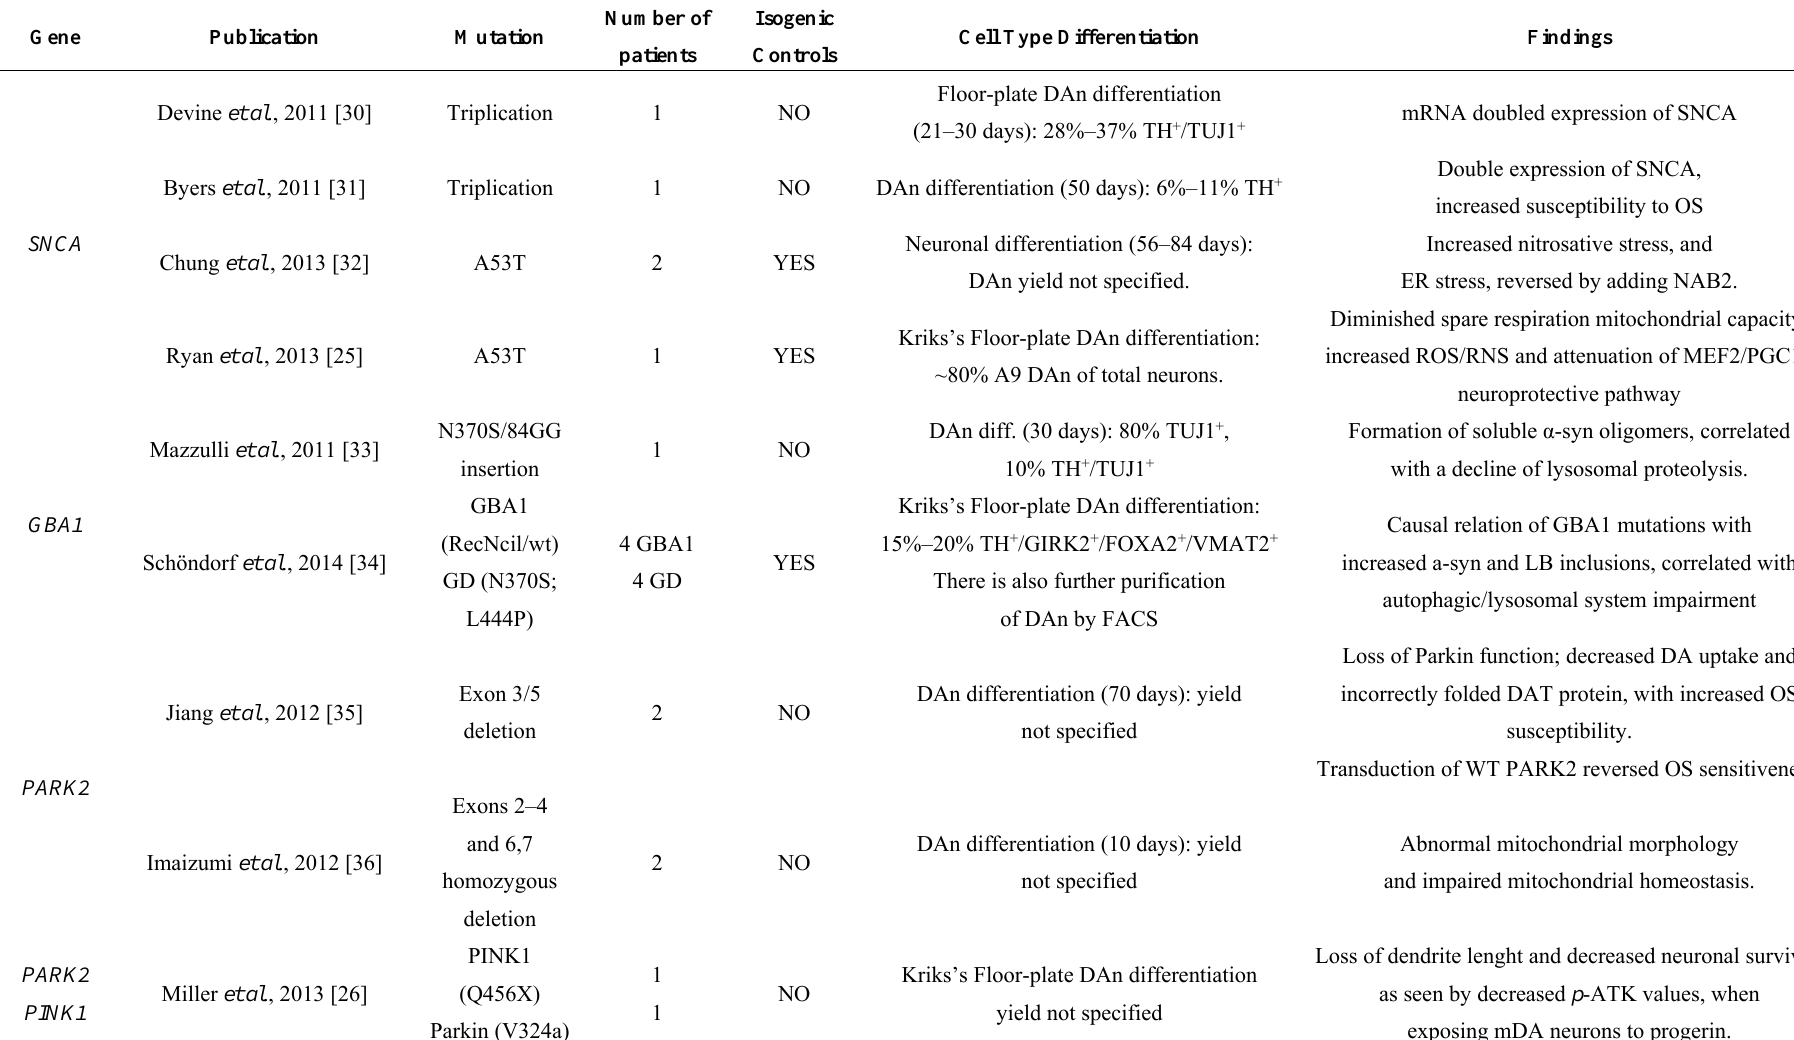
Table 1. Summary of the described PD iPSC modeling publications in this